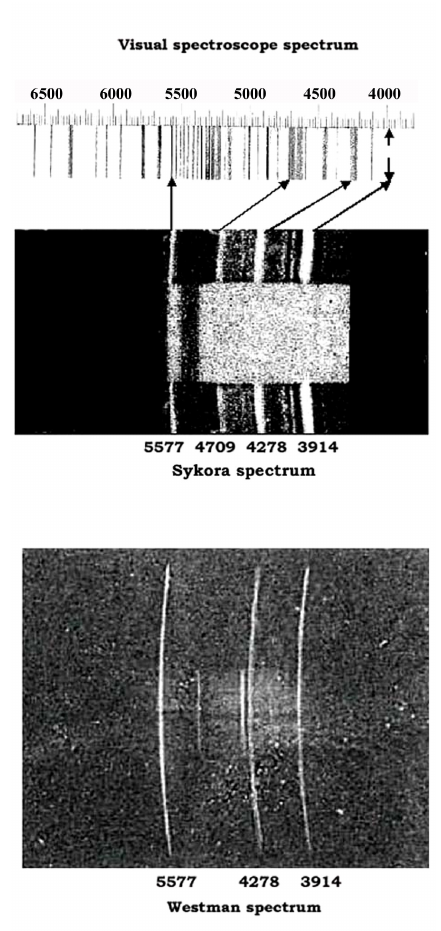
Fig. 20. Auroral spectra obtained by Sykora and Westman, together with calibration spectra and an auroral spectrum constructed ear- lier from visual spectroscope observations (Carlheim-Gyllensk¨old,